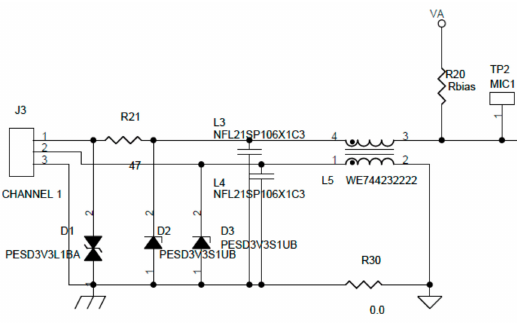
Figure 3. Filter stage for noise minimization and electrostatic discharge (ESD) and electromagnetic interference (EMI) protection.